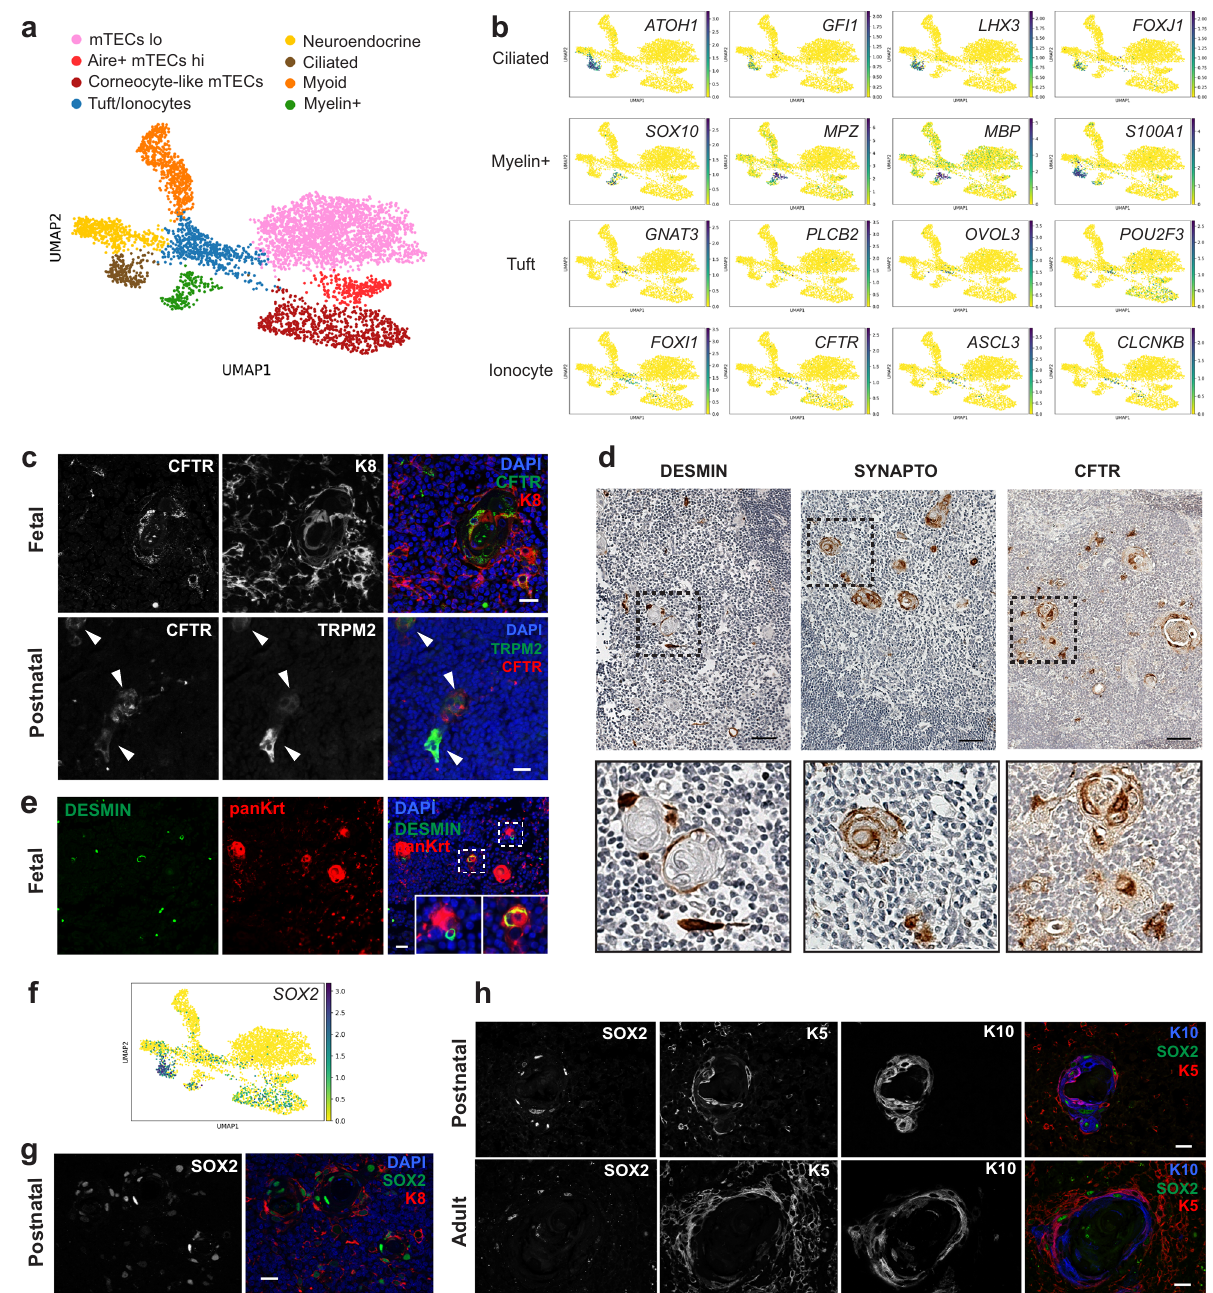
Fig. 6 Tuft cells, ionocytes, ciliated cells, and myelin-expressing cells are present in the human thymic medulla. a UMAP visualization of mTECs, neuroendocrine, myoid, and myelin-expressing cells sub-clustering. b UMAP visualization of the expression of marker genes used for cell cluster identi fi cation. c Immuno fl uorescence analysis of human fetal and postnatal thymus con fi rming the presence of ionocytes positive for KRT8 (red) and CFTR (green) or TRPM2 (green) and CFTR (red) in the medulla. Scale bars, 20 μ m. d Immunohistochemistry staining for ionocytes (CFTR), neuroendocrine cells (SYNAPTO), and myoid cells (DESMIN). Scale bars, 100 μ m. e Immuno fl uorescence analysis showing co-staining of desmin-expressing myoid cells (green) with a wide spectrum cytokeratin antibody (red) in human fetal thymus. Scale bar, 25 μ m. f UMAP visualization of SOX2 expression in medullary epithelial cells. g , h Immuno fl uorescence staining for SOX2 in postnatal and adult thymus con fi rms expression of this transcription factor in the medulla. A subset of SOX2 + cells (green) co-expressed KRT8 (red) ( g ) or KRT5 (red) and/or KRT10 (blue) ( h ). Scale bars, 20 μ m. Staining in c , d , e , g , h was repeated at least twice with similar